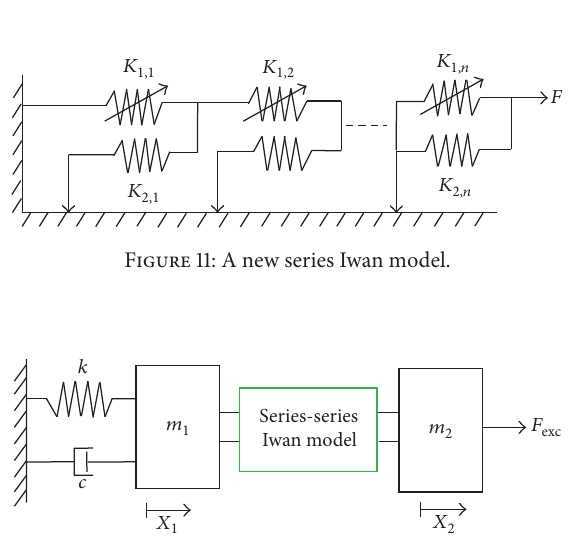
Figure 12: Two-degree-of-freedom nonlinear model with series Iwan element.